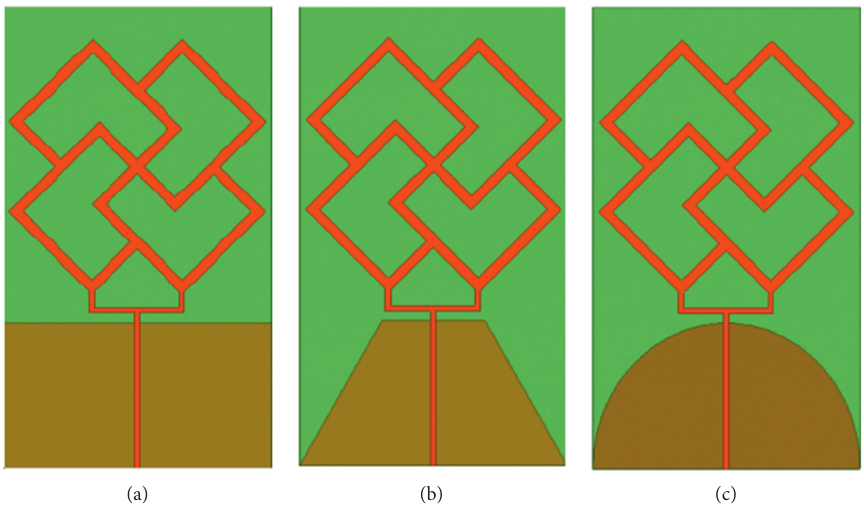
Figure 11: Comparison of ground plates. (a) Rectangular ground. (b) Trapezoidal ground. (c) Oval ground.